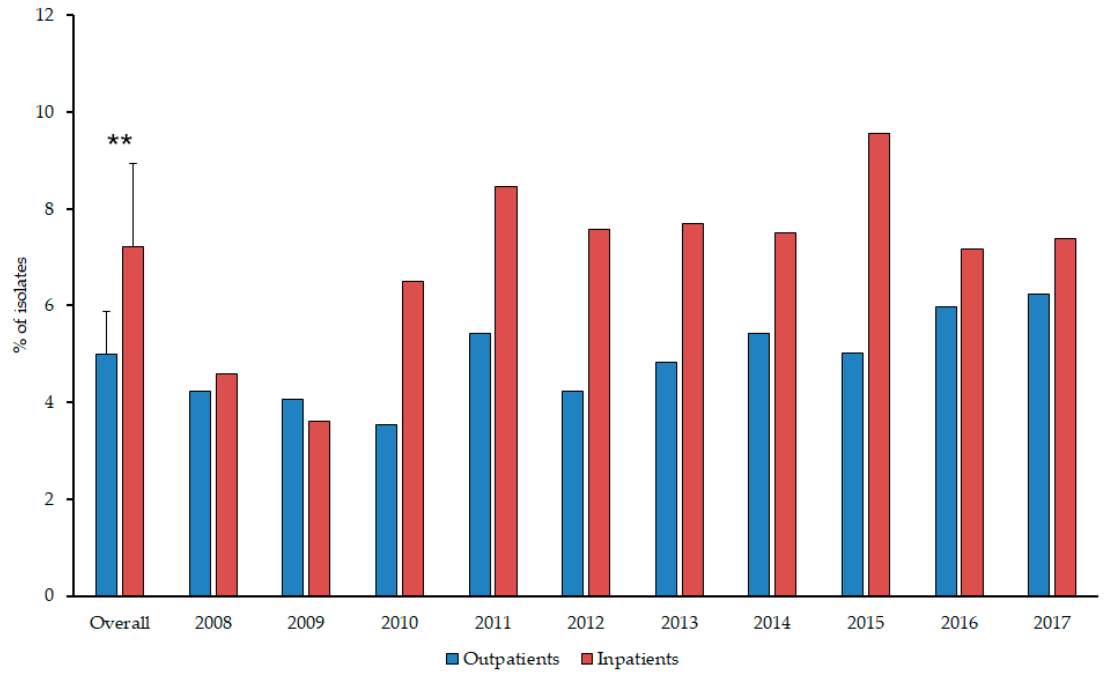
Figure 1. Ratio of Proteae in positive urine samples of inpatients and outpatients during the study period. Table 1. Frequency of co-isolation and species distribution in inpatient and outpatient samples. Isolated co-pathogen